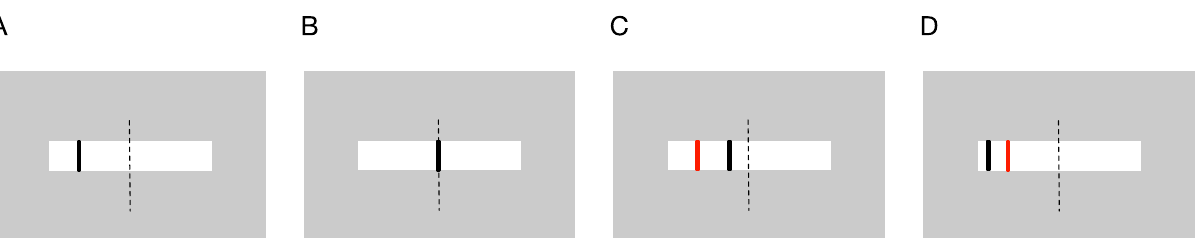
Figure 1. Task conditions. The target was a wide white bar and the cursor was a thin black bar. The target’s length varied over time and moved unpredictably in the horizontal direction. The participants were instructed to track the center of the target, represented as dotted lines, using the cursor. In the complete control condition ( A ), all joystick operations were reflected in the cursor movement. In the full automation condition ( B ), no joystick operation was reflected in the cursor movement, and the cursor was always at the center of the target. In the assistive automation conditions ( C ), the cursor was always displayed to reduce the tracking error, the distance between the center of the target and the position of the actual cursor, represented by the thin red bar. In the obstructive automation conditions ( D ), the cursor was always displayed to increase the tracking error (the actual cursor is again represented by the thin red bar). Participants could not see the actual cursor movement in this to 2004 pixels over time as the sum of two sinusoidal functions with different frequencies independent of its movement. The cursor was a thin black bar (width × height: 5 × 50 pixels) located on the target (see Fig. 1A). The participants tracked the center of the target by controlling the cursor with a joystick (Logitech Extreme 3D Pro) using both hands. The angle of the joystick with respect to its original position corresponded linearly to the hori- zontal distance between the cursor and the center of the screen. The x-coordinate of the position of the cursor bar was recorded at intervals of 1/60 s. The presentation of the stimuli and the recording of the tracking trajecto- ries of the participants were controlled by a computer with MATLAB software and its Psychtoolbox extension 16 . The computer automatically modulated the movement of the cursor. The levels of automation were varied from complete control to full automation. In the complete control condition (Fig. 1A), all joystick operations